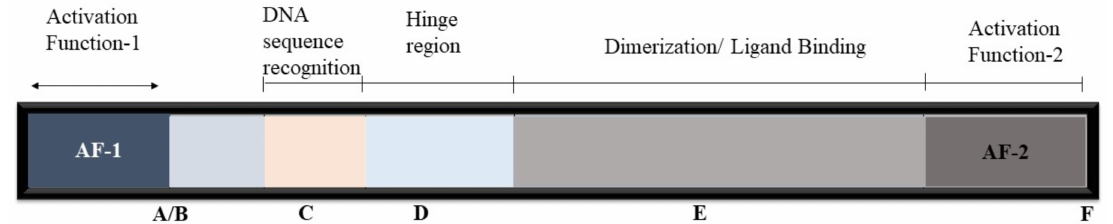
Figure 1. General basic association of atomic receptors [9]. Letters from A to F represented the domains of nuclear receptors from N-end to